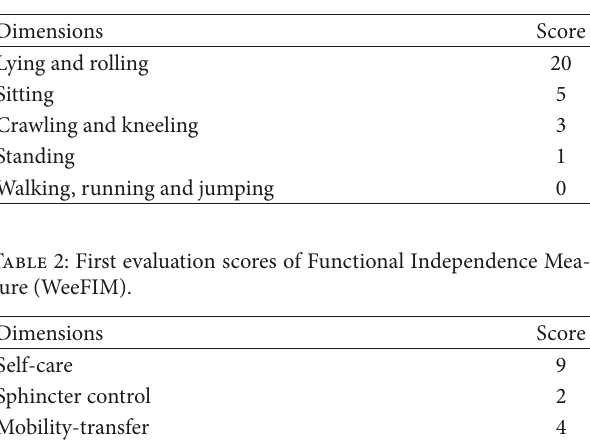
Table 1: First evaluation scores of Gross Motor Function Measure (GMFM).